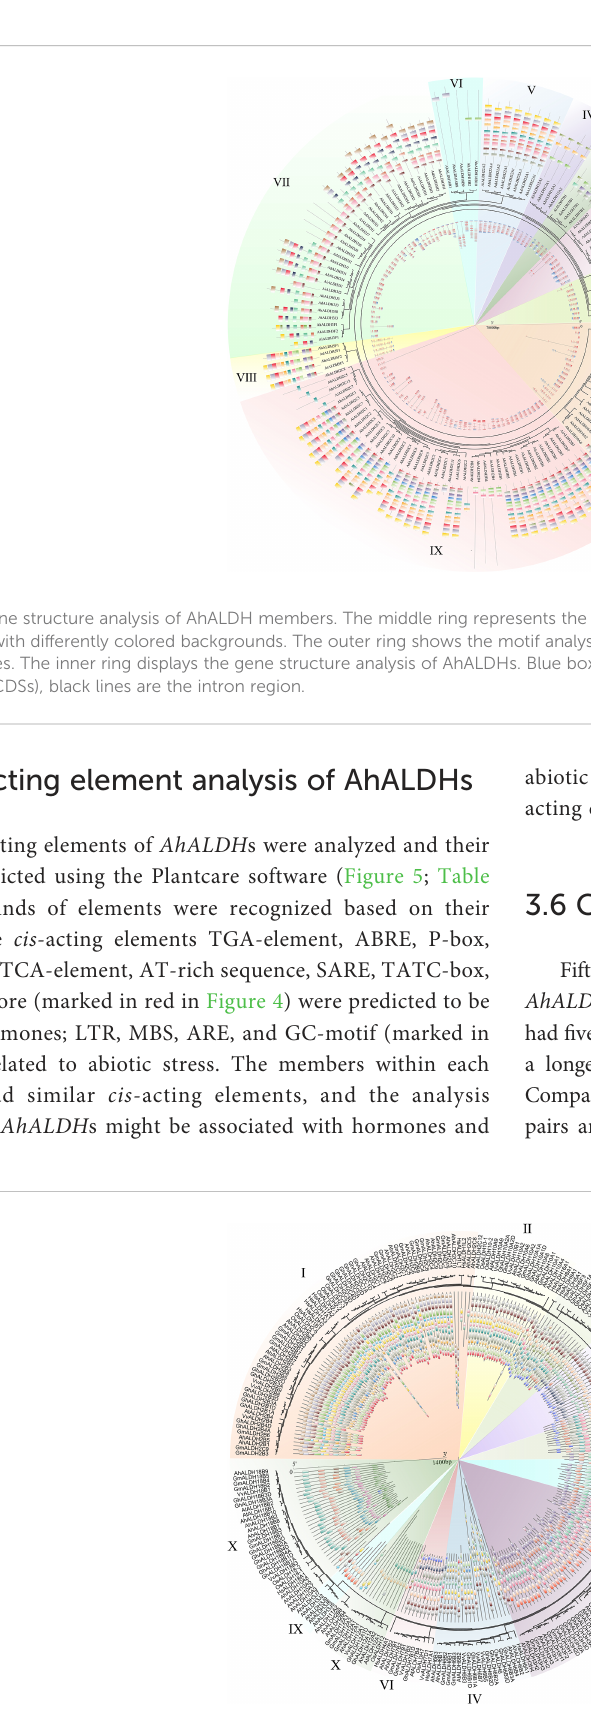
FIGURE 4 Analysis of ALDH members in seven species. The seven species were groundnut ( Ah ), Arabidopsis ( At ), rice ( Os ), human ( Hs ), cotton ( Gh ), soybean ( Gm ), and grape ( Vv ). Differently colored backgrounds represent different subfamilies. The inner circle represents the motifs of ALDH members; different squares show different